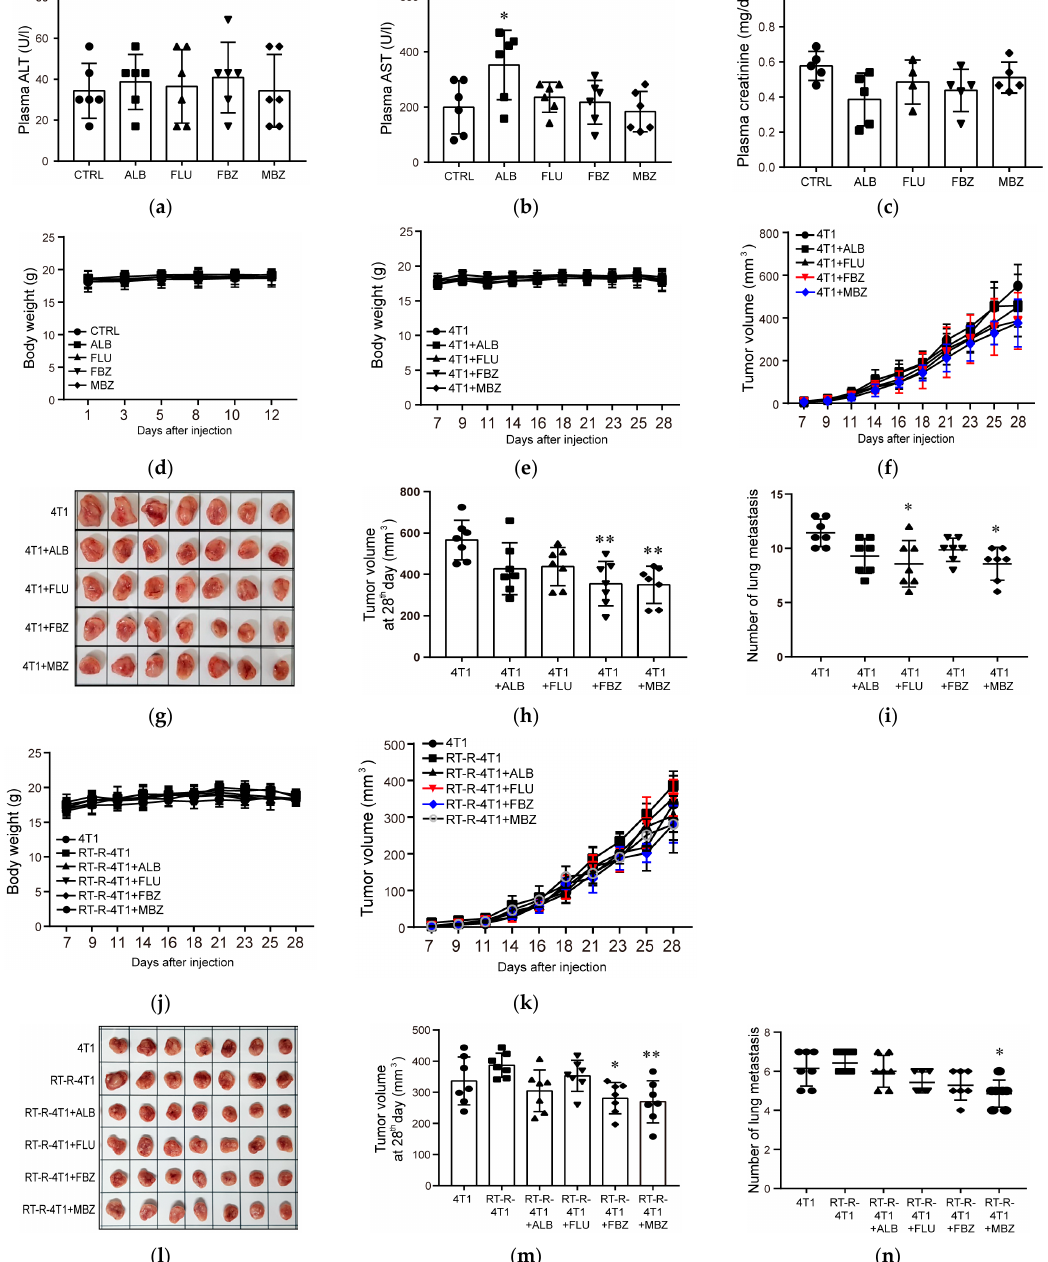
Figure 4. MBZ exerts the strongest anticancer effect among the benzimidazole derivatives on 4T1 and RT-R-4T1 tumor allografts in athymic nude mice. ( a – d ) For the safety test, the mice were divided into five groups (six mice/group) and treated with ALB, FLU, FBZ, or MBZ (10 mg/kg/mL) by oral gavage daily for 2 consecutive weeks on a schedule of 5-days-on and 2-days-off. After 2 weeks, the mice were sacrificed and plasma alanine aminotransferase (ALT) ( a ), aspartate aminotransferase (AST) ( b ), and creatinine levels ( c ) were measured. Body weights ( d ) were measured three times a week for 4 weeks. The data represent the mean ± SD (* p < 0.05). ( e – n ) 4T1 cells or RT-R-4T1 cells (5 × 10 4 cells/100 µ L) were injected subcutaneously, and when tumor volumes reached 100 mm 3 (2 weeks after tumor injection), mice were divided into 10 groups ( n = 7/each group): (1) 4T1 group, (2) 4T1 group + ALB, (3) 4T1 group + FLU, (4) 4T1 group + FBZ, (5) 4T1 group + MBZ, (6) RT-R-4T1 group, (7) RT-R-4T1 group + ALB, (8) RT-R-4T1 group + FLU, (9) RT-R-4T1 group + FBZ, (10) RT-R-4T1 group + MBZ for 2 consecutive weeks on a schedule of 5-days-on and 2-days-off. Body weights ( e , j ) and tumor volumes ( f , k ) were measured three times a week from 7 days after tumor cell injection. The mice were sacrificed on the 28th day after injection, and tumor volumes and ( g , h , l , m ) lung metastasis ( i , n ) were measured. The data represent the mean ± SD (* p < 0.05; ** p <